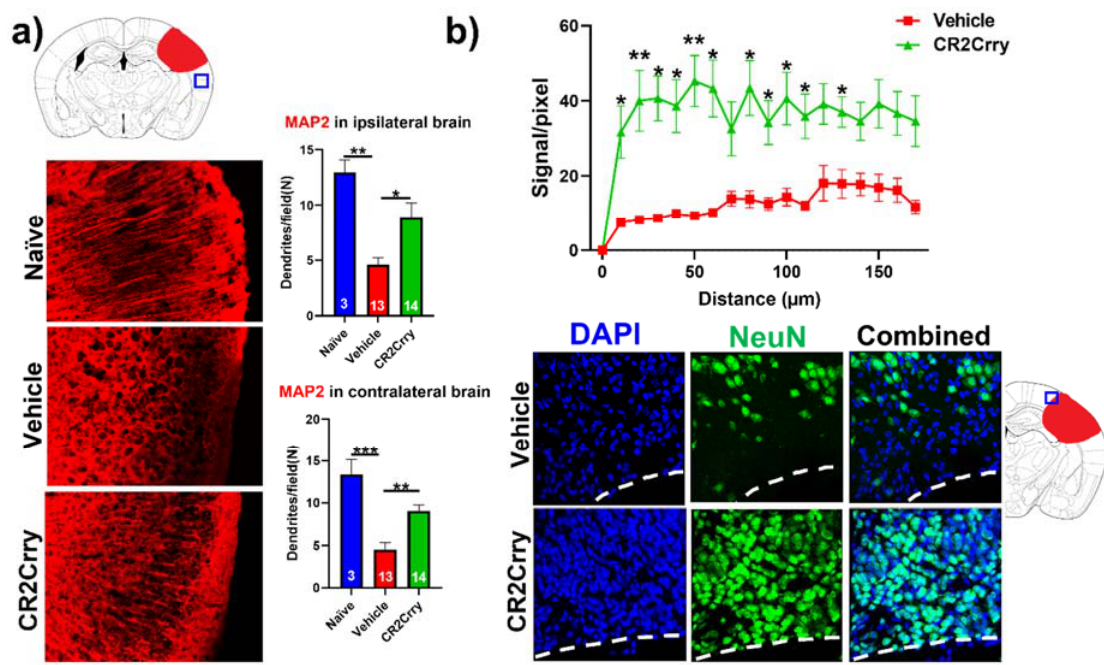
Figure 6. CR2Crry treatment decreases neurodegeneration by maintaining dendritic arborization and halting neuronal loss. ( a ) Representative IF images of dendritic processes (MAP2) of cortical tissue in the ipsilateral hemisphere and quantification of MAP2 dendritic density in both the ipsilateral and contralateral hemisphere of naïve, vehicle, and CR2Crry animals. One-way ANOVA with Bonferroni’s correction for multiple comparisons. * p < 0.05, ** p < 0.01, *** p < 0.001. Error bars = mean ± SEM. ( b ) Representative IF images of NeuN-stained sections of the perilesional area, and quantification of NeuN signal starting from lesion border inward toward the ipsilateral cortical tissue. Two-way ANOVA with Bonferroni’s correction for multiple comparisons. * p < 0.05, ** p < 0.01. n = 15 for vehicle, and n = 14 for CR2Crry. Error bars = mean ± SEM. No data points were excluded from the analysis.